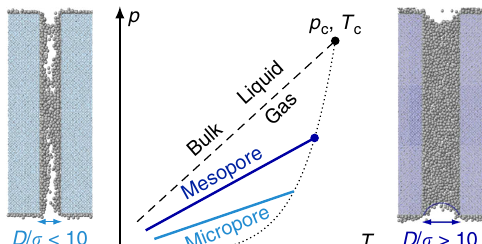
Fig. 1 Criticality in con fi ned fl uids. Shift in the gas/liquid transition for a fl uid having a molecular size σ con fi ned in a nanopore of a diameter D . On the one hand, in mesopores, typically for D ≳ 10 σ , the fl uid can be treated using a continuum model which rests on capillarity ingredients such as the surface tension, radius of curvature of the gas/liquid interface, etc. ( right ). On the other hand, in micropores, typically for D ≲ 10 σ , the molecular granularity of the fl uid has to be taken into account and continuum models no longer apply ( left ). For a given pore size D , the bulk gas/liquid coexistence (dashed line) and the bulk critical point p c , T c (black sphere) are shifted to lower pressure and temperature with a scaling that depends on D . In particular, upon con fi nement in a pore of a size D , the critical